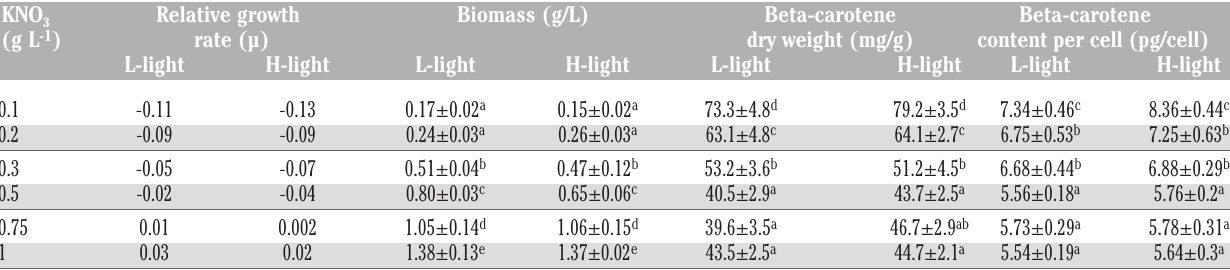
concentration. 3